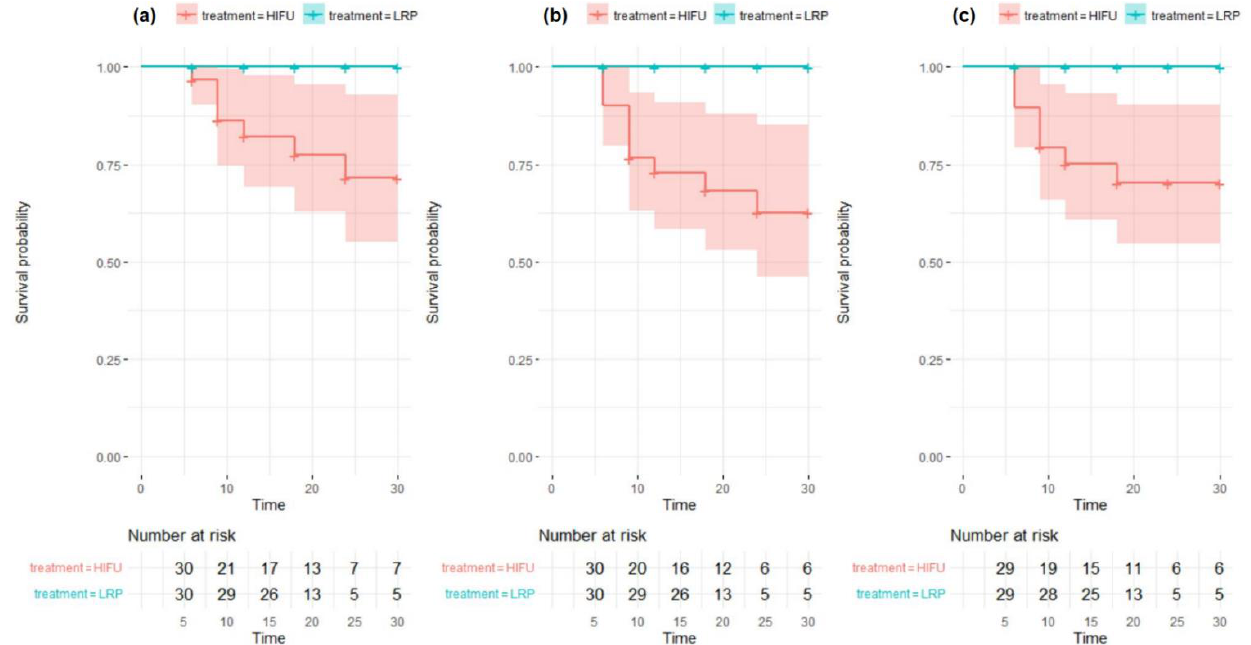
Figure 1. Kaplan–Meier curves presenting differences in failure-free survival between the highly-intensive focused-ultrasound (HIFU) and laparoscopic radical prostatectomy (LRP) groups: ( a ) treatment failure (TF) defined as a prostate-specific antigen (PSA) rise >1.2 ng/mL above the nadir, ( b ) TF defined as either PSA rise >1.2 ng/mL above the nadir or positive biopsy on follow-up, ( c ) TF defined as positive biopsy on follow-up.